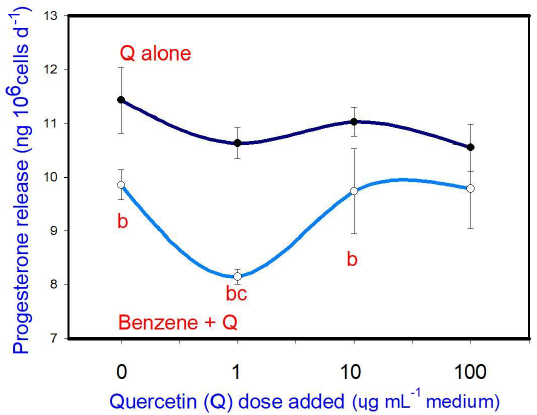
Figure 4. Effects of benzene, quercetin extract, and their combi- nation on the release of oxytocin in cultured porcine ovarian gran- ulosa cells. Parts marked “a” show the effect of quercetin extract (significant difference ( P< 0 . 05) between cells cultured without and with quercetin addition at three different levels without ben- zene), b the effect of benzene (significant difference ( P< 0 . 05) be- tween cells cultured with or without benzene for each quercetin dose separately), c the effect of quercetin extract at simultaneous benzene presence (significant difference ( P< 0 . 05) between a cell cultured with and without quercetin addition at three different lev- els with simultaneous benzene addition); effect of benzene alone (20µgmL − 1 ) is displayed for quercetin dose at 0µgmL − 1 .